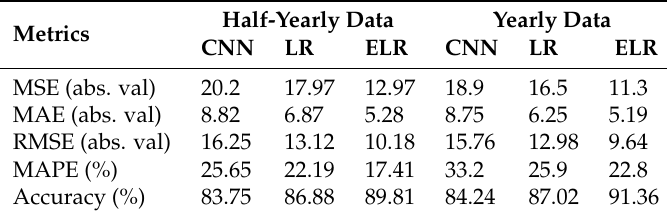
Table 14. Load performance metrics comparison for one week using the UMass Electric Dataset.